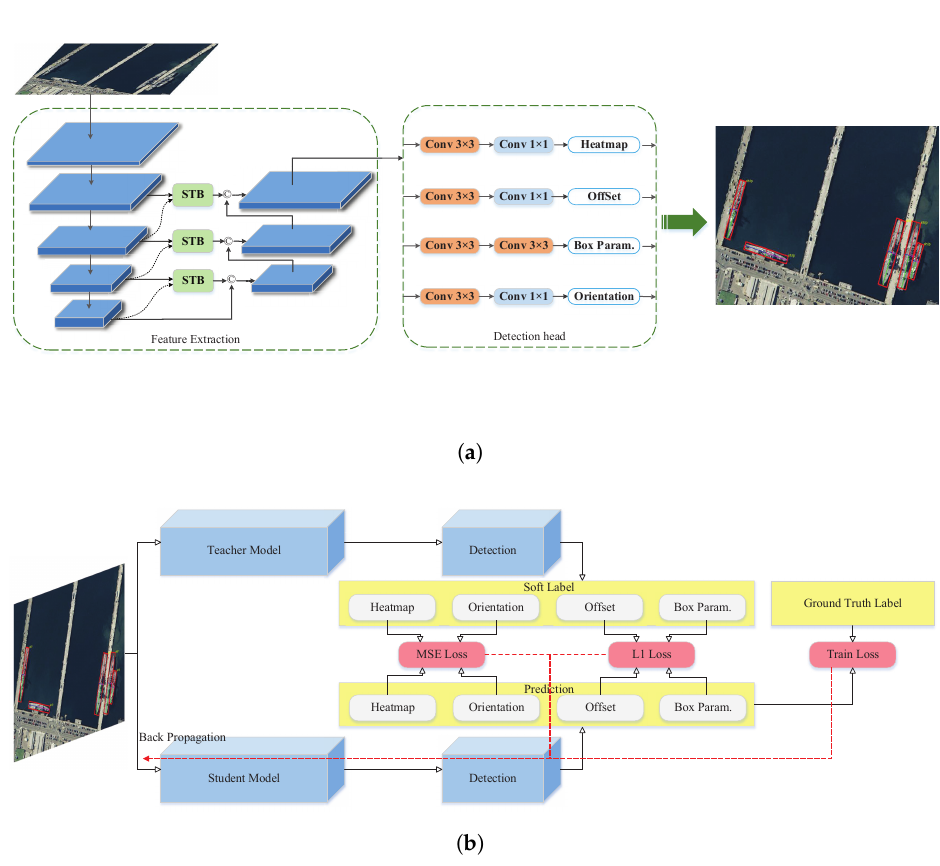
Figure 1. The overall framework of our method: ( a ) a keypoint-based oriented object detection network for remote sensing images. STB denotes the semantic transfer block; ( b ) the heatmap and orientation from teacher and student networks are aligned via the mean square error, and the heatmap and offset and box parameters are aligned via the L 1